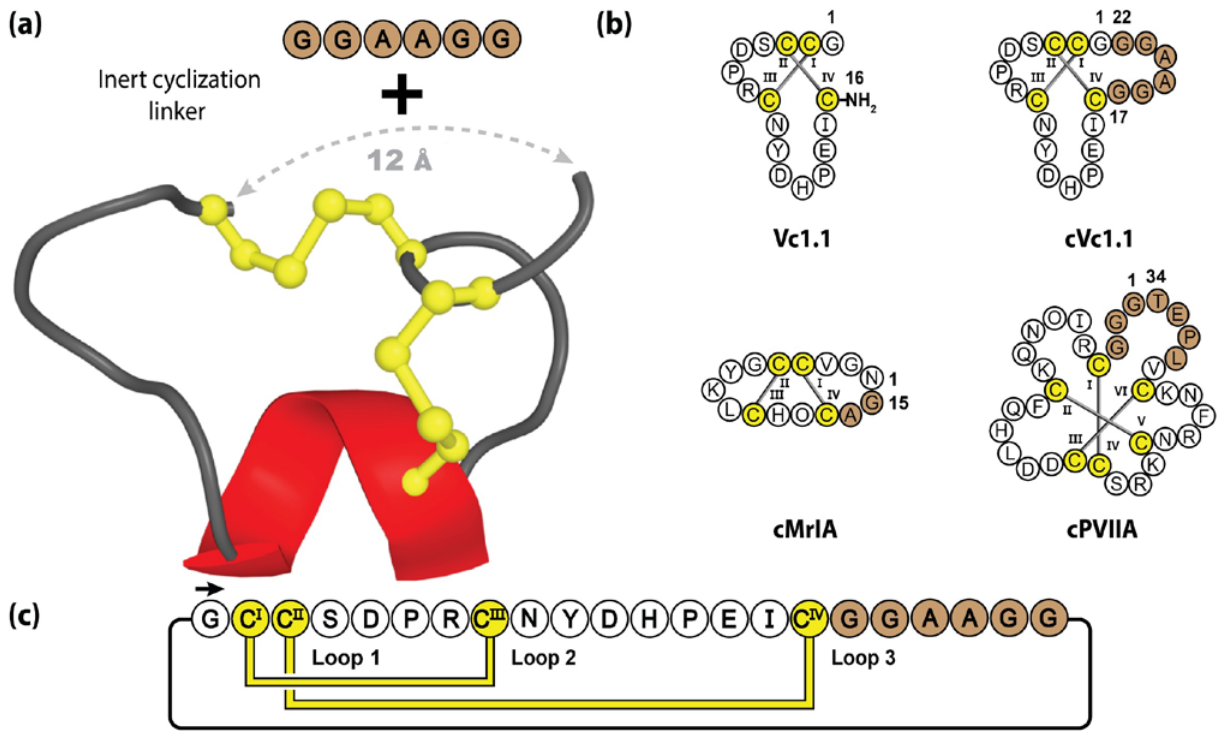
Figure 7. Structure and sequence of α-conotoxin Vc1.1 and three engineered cyclic conotoxin variants. ( a ) Three-dimensional structure of synthetic Vc1.1, with engineered inert cyclization linker. ( b ) Peptide sequence of Vc1.1 and three different engineered cyclic conotoxin variants. ( c ) Amino acid sequence, disulfide bond connectivity and loop nomenclature of cVc1.1. Cysteine residues are numbered and highlighted in yellow, with the engineered sequences represented by brown shading.